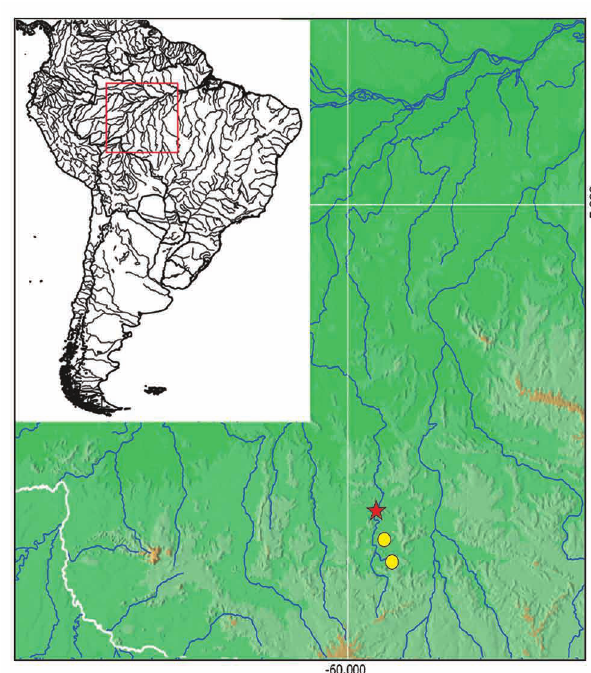
Fig. 6. Map of the geographic distribution of Geophagus mirabilis . Star corresponds to type-locality; circles correspond to other localities where the species is found. One symbol can correspond to more than one